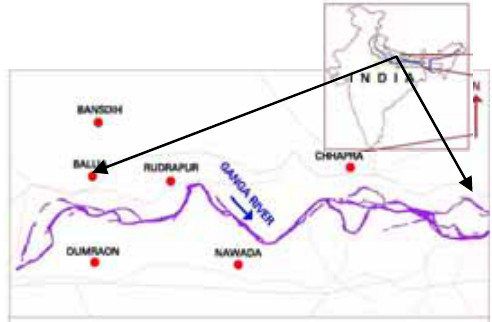
Figure 1: Location map of the study